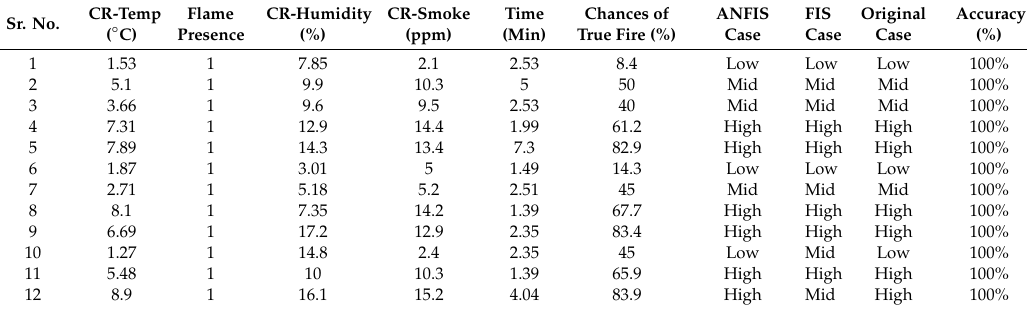
Table 10. Comparison of original case, ANFIS case, and FIS case.